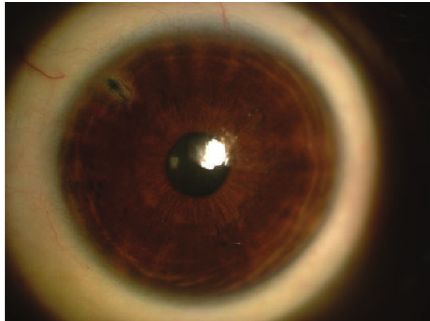
Figure 3: YAG-laser peripheral iridotomy on the left eye.